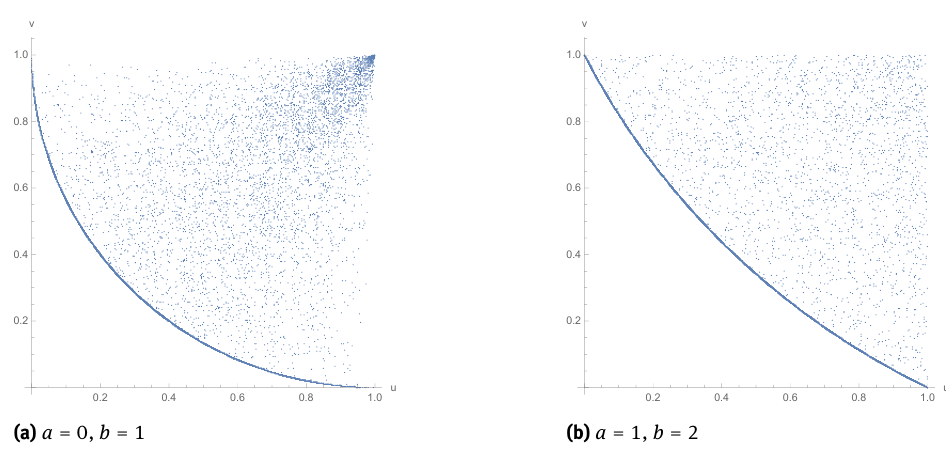
Figure 12: Two simulations from a uniform Lorenz copula with X ∼ U [0, 1] and X ∼ U [1, 2] .